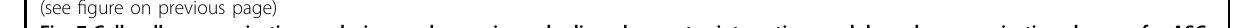
Fig. 7 Cell – cell communication analysis reveals a perivascular ligand – receptor interaction module and communication changes for ASCs in cancer-related lymphedema. a Intercellular communication networks in the adipose tissues from patients with lymphedema (CASE; right panel) and healthy people (CTRL; left panel). The total number of communications is shown for each cell lineage. The line color indicates that the ligands are broadcast by the cell lineage in the same color. The line thickness is proportional to the number of broadcast ligands. b Heatmap shows the number of communications between any two lineages in the CASE (right panel) and CTRL (left panel) groups. c The ligand – receptor pairs showing signi fi cant changes in speci fi city between any one of the non-ASC lineages and ASCs in CASE versus CTRL. ASCs express receptors and receive ligand signals from other lineages. The dot size re fl ects the p value of the permutation tests for lineage speci fi city. The dot color denotes the mean of the average ligand – receptor expression in the interacting lineages. d The ligand – receptor pairs showing signi fi cant changes in speci fi city between ASCs and any one of the non-ASC lineages in CASE versus CTRL. ASCs express ligands and broadcast ligand signals for other lineages. ASC, adipose-derived stromal/stem/progenitor cell; BC, B cell; CASE, cancer-associated lymphedema; CTRL, healthy control; DC, dendritic cell; EDO, endothelial cell; MAC, macrophage; NK, natural killer cell; NKT, natural killer T cell; TC, T